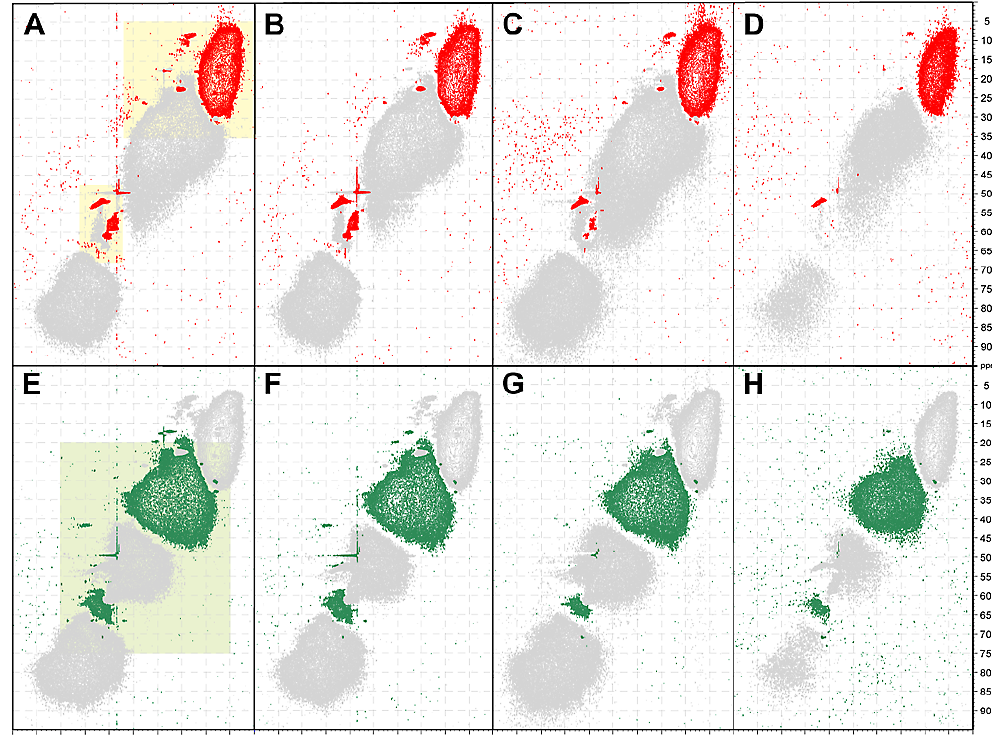
Fig. 7. DEPT-HSQC NMR spectra of four marine SPE-DOM; aliphatic ( HC C and HC X, with X=O, N, S) section with methyl (red) and methylene (green) cross peaks indicated; boxes denote ranges for cross-peak assignments given in Fig. 8, yellow: CH 3 -selective, and green: CH 2 -selective DEPT-HSQCNMR spectra. Top panel: CH 3 -selective DEPT-HSQCNMR spectra (CH 3 : red, CH and CH 2 : gray); lower panel: CH 2 -selective DEPT-HSQCNMR spectra (CH 2 : green, CH 3 and CH: gray). (A, E) 5m (near-surface photic zone); (B, F) 48m (fluorescence maximum); (C, G) 200m (upper mesopelagic zone); and (D, H) 5446m (30m above